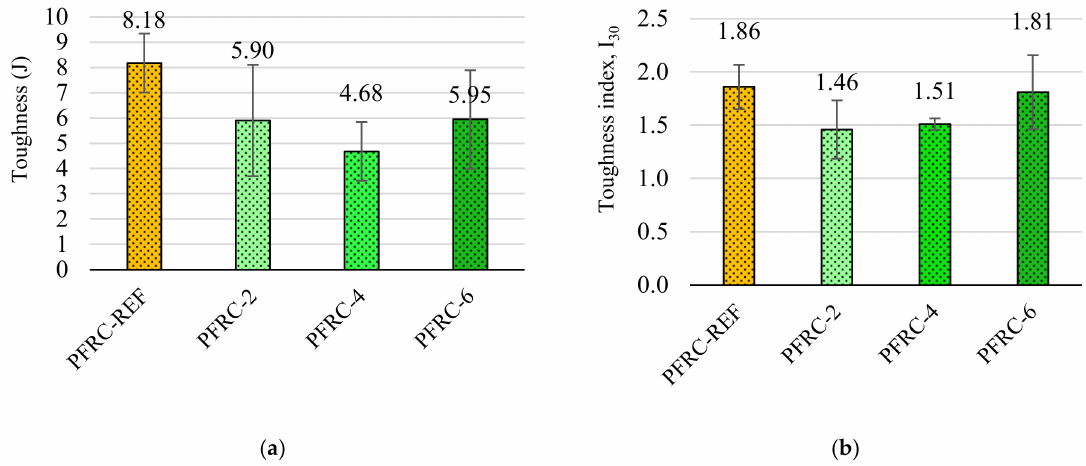
Figure 7. Values of toughness ( a ) and toughness index ( b